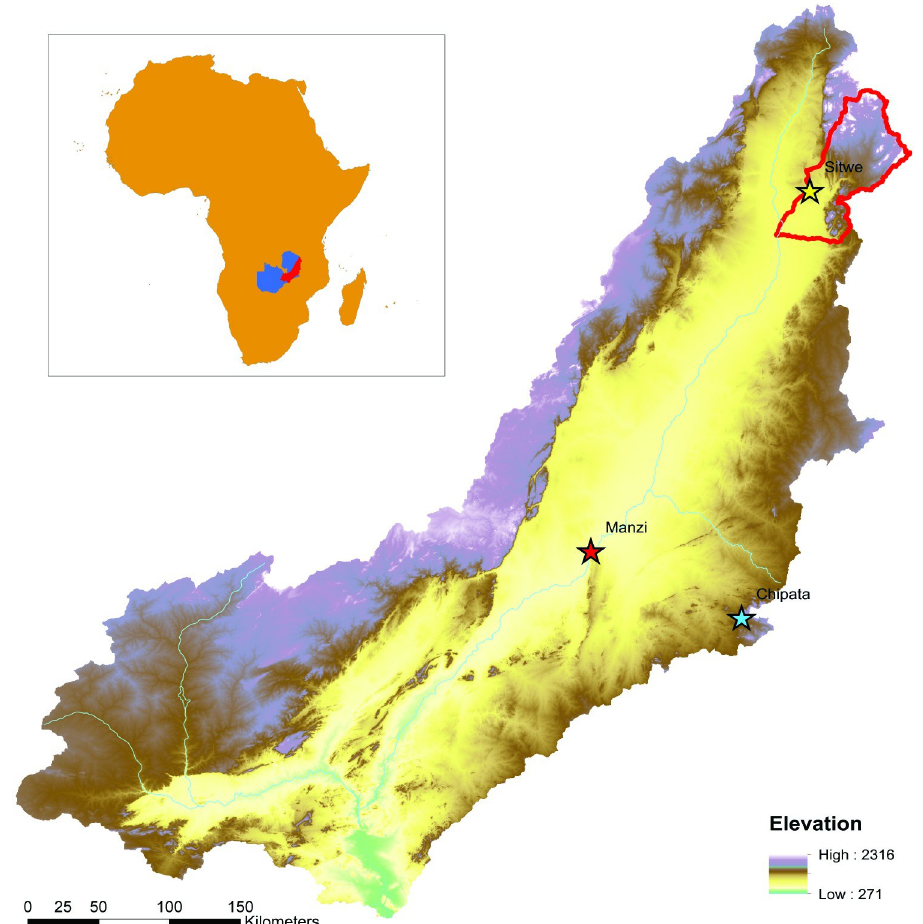
Fig 1. The Luangwa Valley, Zambia. The fieldwork location in the piedmont zone of northeastern Luangwa is highlighted in red. SRTM digital elevation map reprinted from USGS Earth Resources Observatory and Science (EROS) Center (public domain):